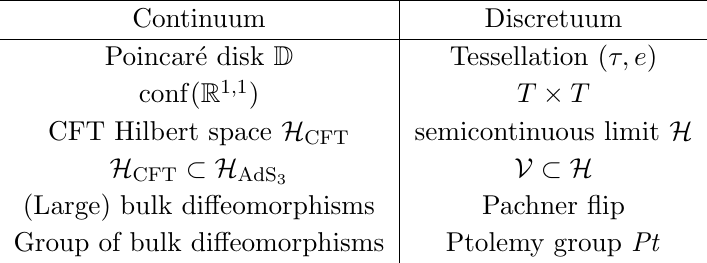
Table 1 . Holographic dictionary for the Pt =T